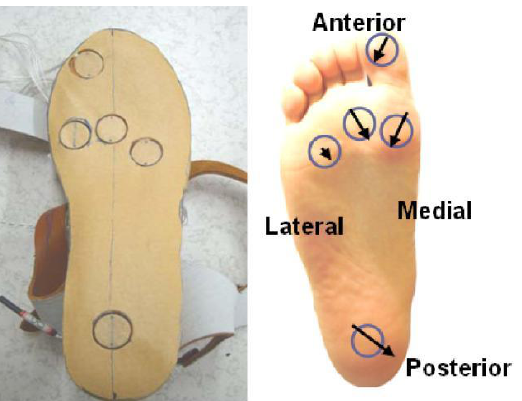
Figure 18. Mounted transducer in high-heeled shoe